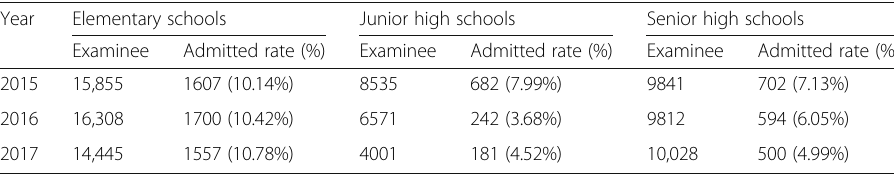
Table 5 Employment rate during 2015 – 2017 — elementary, junior and senior high school